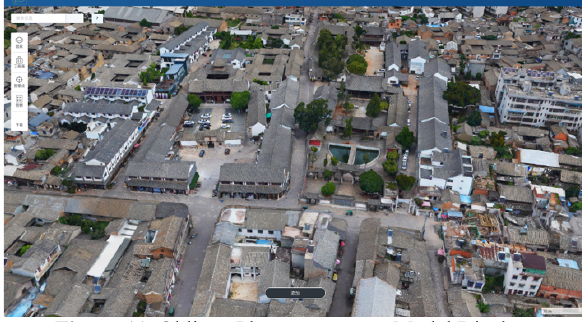
Figure 11 . Oblique Photogrammetry Model Display.